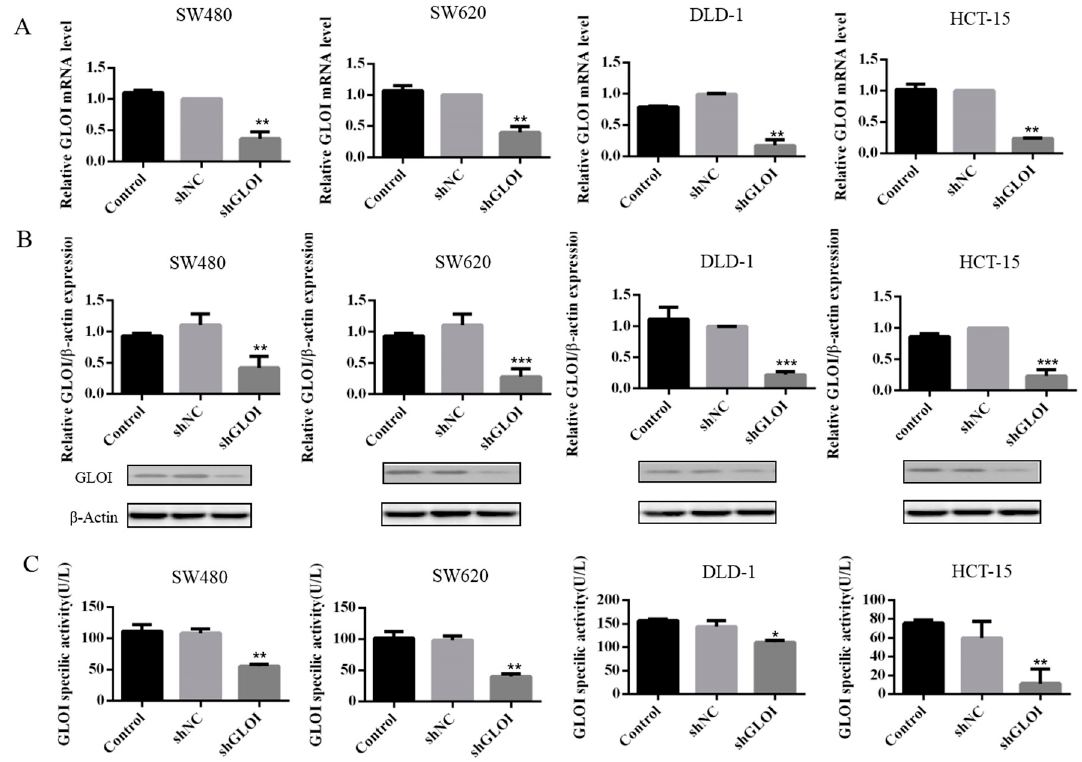
Figure 2. GLOI knockdown suppresses expression of GLOI mRNA, protein, and enzyme activity in colorectal cancer (CRC) cells. The expression of GLOI mRNA ( A ), GLOI protein ( B ), and GLOI enzyme activity ( C ) was lower in SW480, SW620, DLD-1, and HCT-15 CRC cells transfected with short hairpin GLOI (shGLOI) than in cells transfected with short hairpin empty vector (shNC). * p < 0.05, ** p < 0.01, *** p < 0.001. All data are representative of three independent experiments ( n = 3).